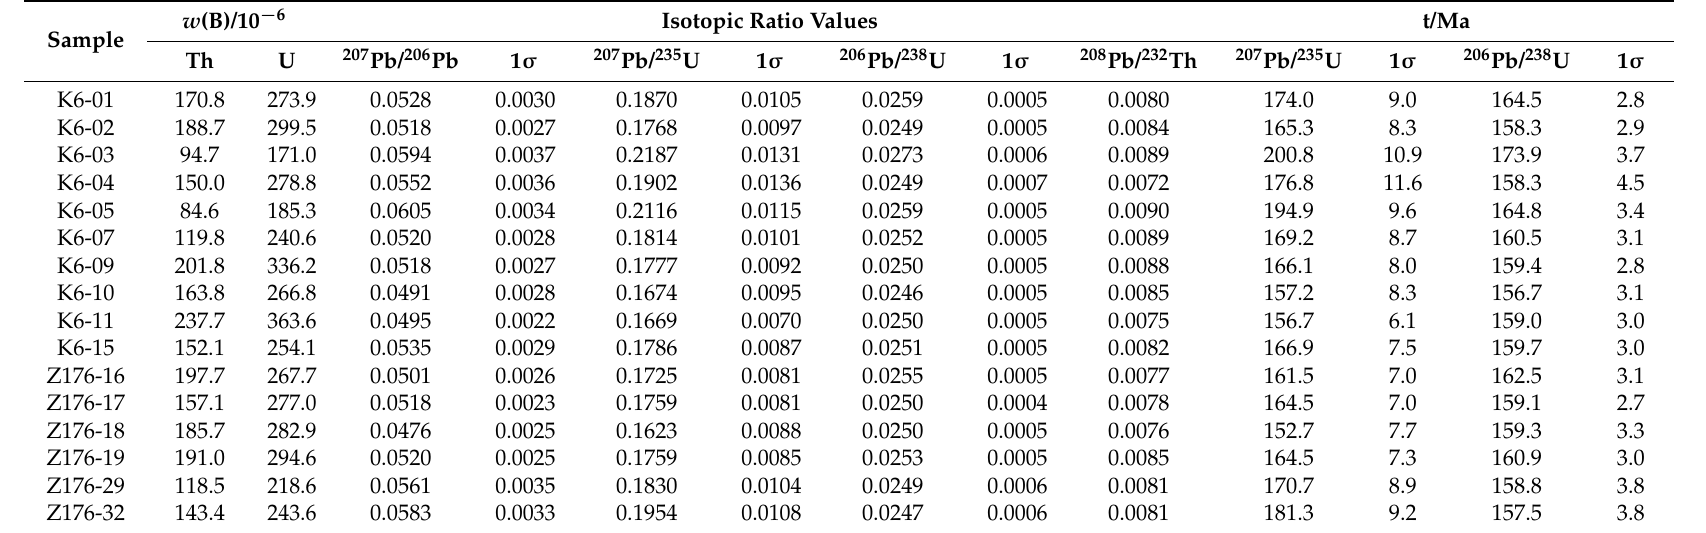
Table 6. The results of zircon U–Pb geochronology of the Xiajinbao